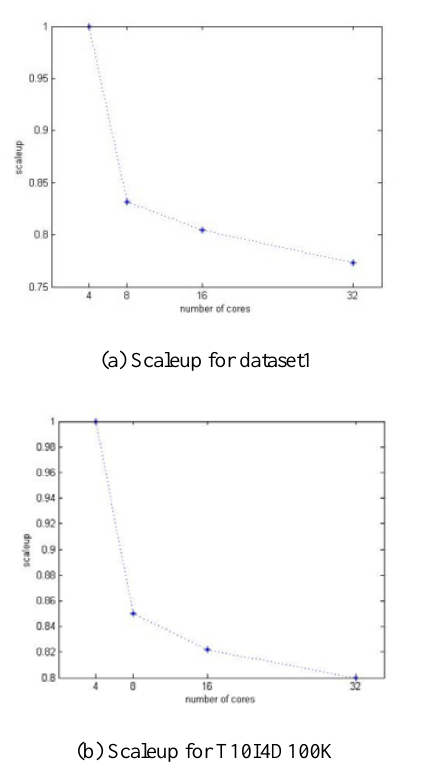
Figure4. Scaleup performance evaluation